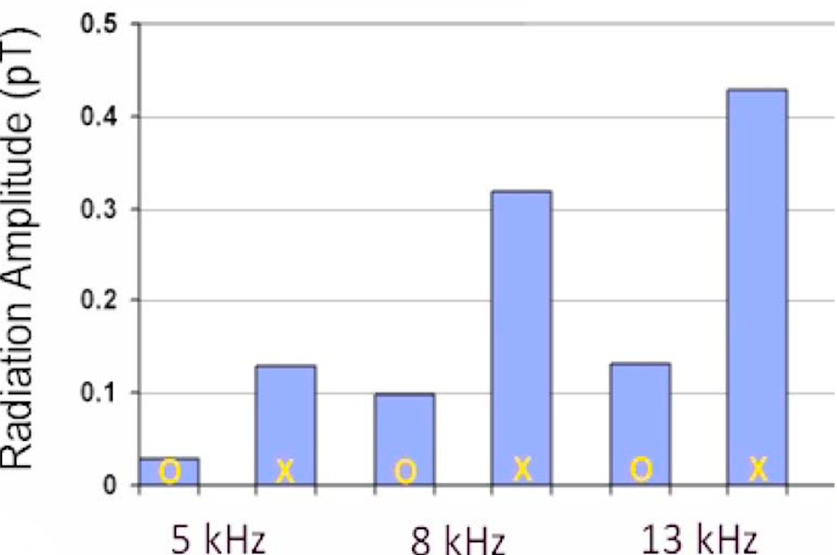
Figure 3. The averaged radiation amplitudes of VLF waves at several modulated frequencies (5 kHz, 8 kHz, 13 kHz) generated by the O- and X-wave BW modulation (reproduced with permission from Kuo, S., Snyder, A., Kossey, P., Chang, C.L., Labenski, J., VLF wave generation by beating of two HF waves in the ionosphere; published by John Wiley & Sons, 2011 [11]).